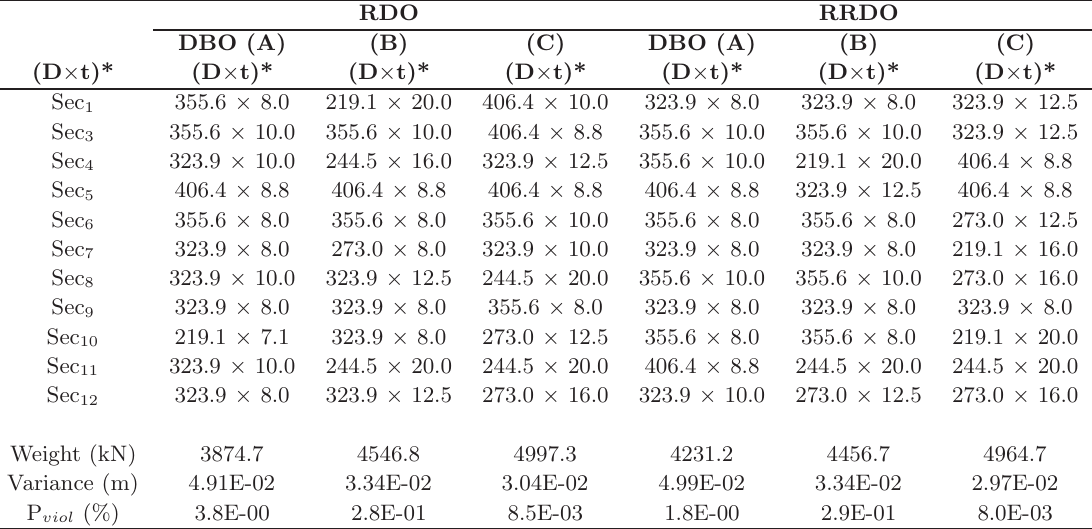
Table 4. 3D truss tower example: characteristic optimal